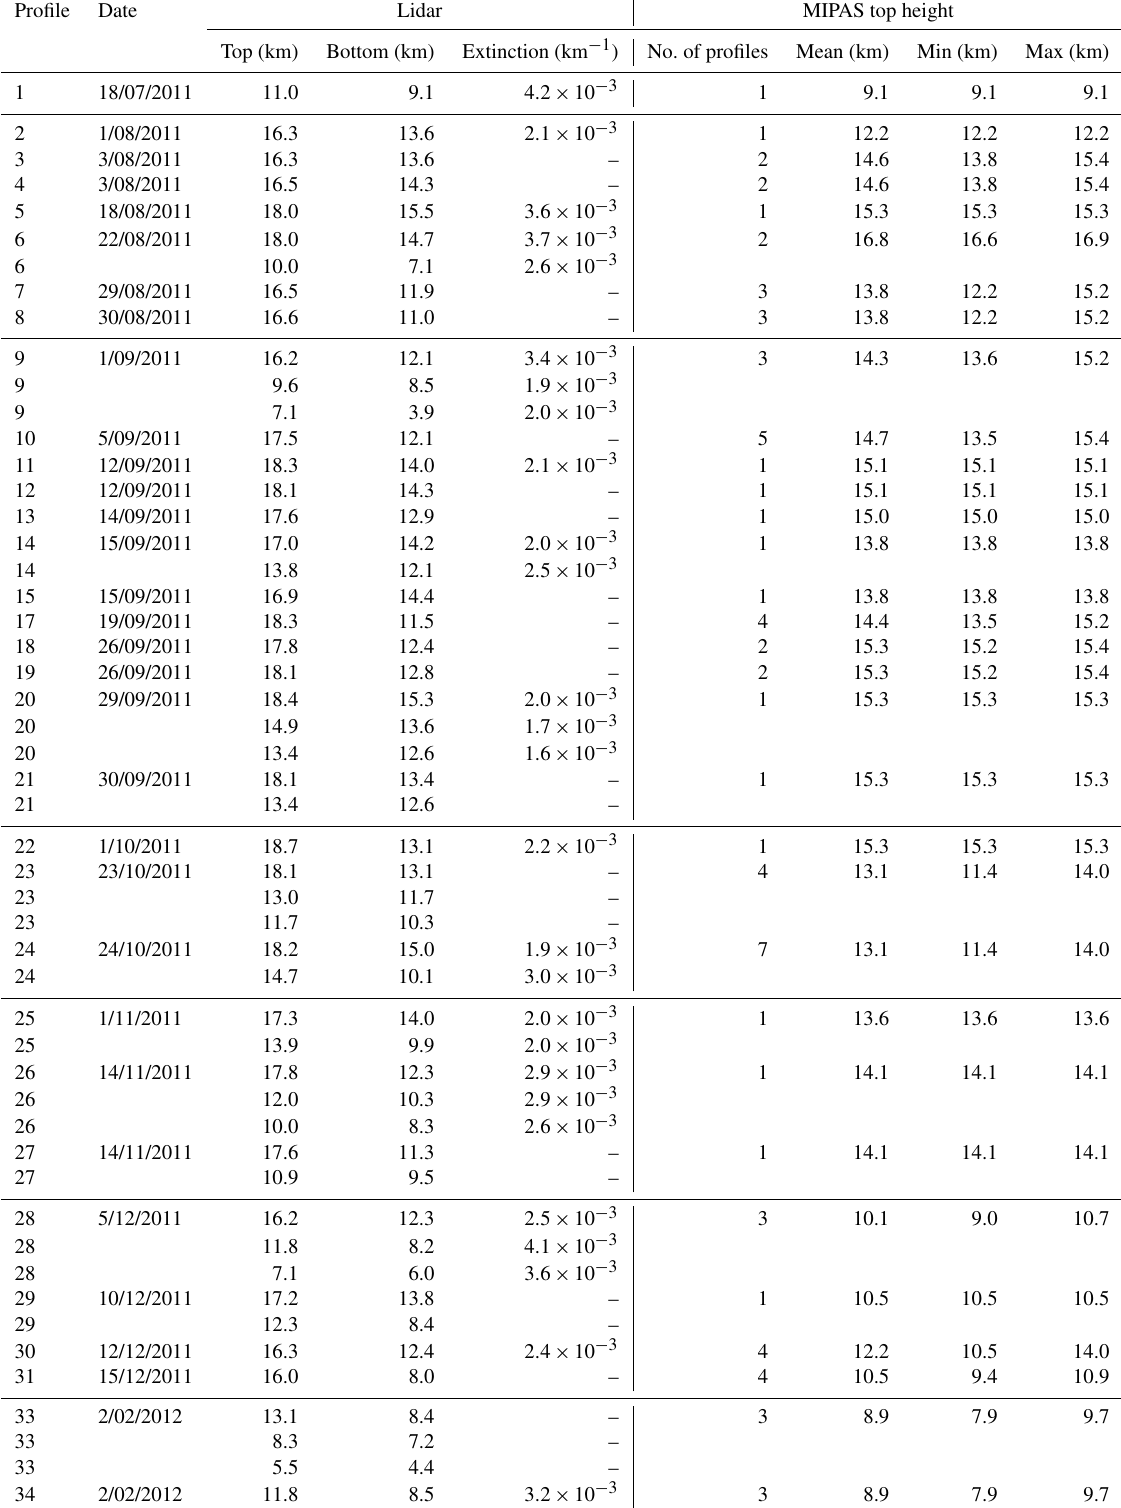
Table 5. Nabro sulfate aerosol measured by the Leipzig lidar and MIPAS. For the lidar data aerosol layer top, bottom, and mean extinctions (for nighttime profiles) are given. For MIPAS, the number of matching profiles, the mean cloud top height, and the corresponding minimum and maximum top heights are